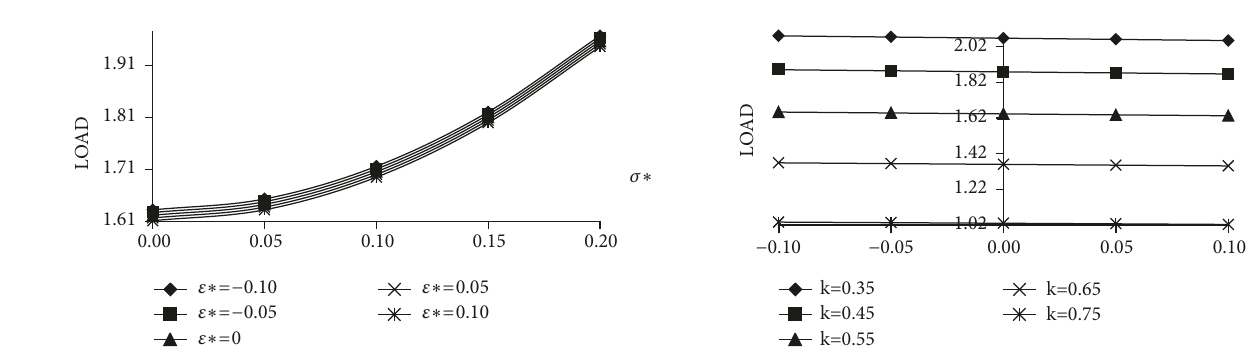
Figure 12: Distribution of load bearing capacity with respect to 𝜎 ∗ and 𝜀 ∗ .